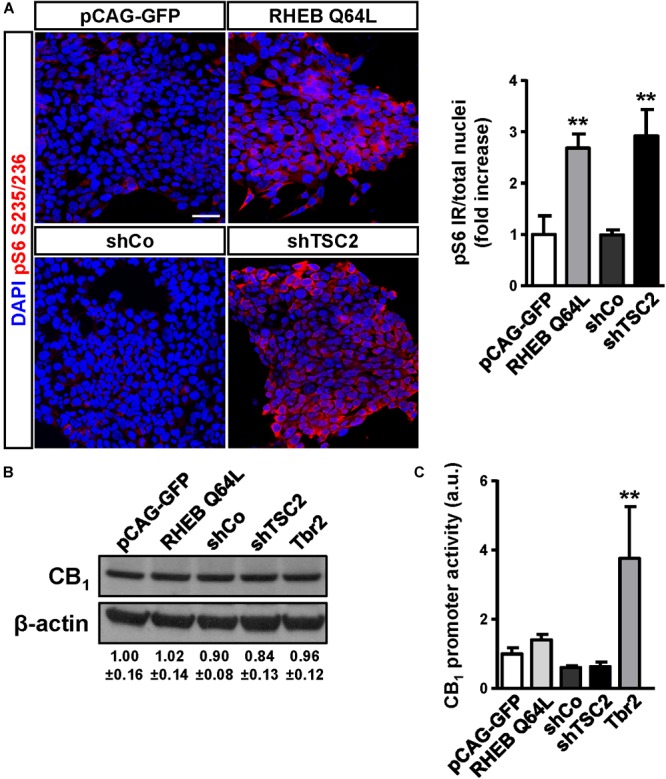
The mTORC1 pathway does not regulate CB1 receptor expression. (A) Characterization of mTORC1 activation in P19 cells after transfection with the Rheb constitutive active mutant Q64L, shTSC2, a scrambled shRNA encoding vector (shCo), or GFP encoding plasmid. mTORC1 activation was analyzed by means of phospho-S6-positive cells quantification. Scale bar: 50 μm. (B) Western blot analysis of CB1 receptor levels in the same conditions as above. Representative immunoblot luminograms for CB1 and β-actin as loading control are shown and quantification is provided (mean ± SEM, n = 3). (C) CB1 receptor promoter activity was analyzed using a CAT construct 24 h after transfection (n = 6). Statistical comparison versus the corresponding control samples, ∗∗p < 0.01.